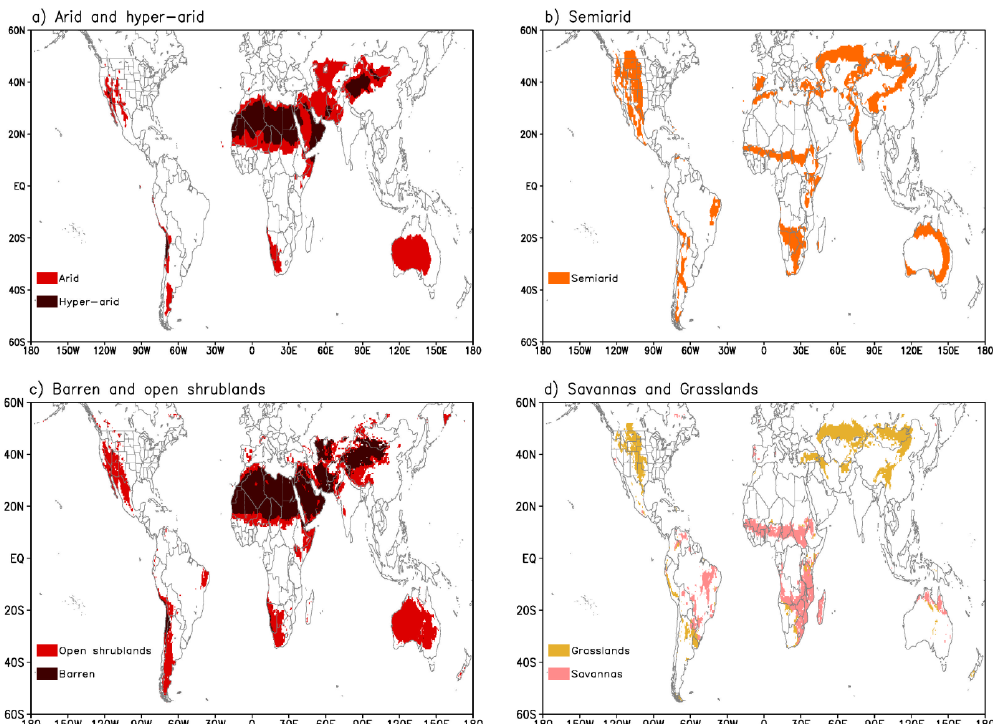
Fig. 2. Global distribution of (a) arid and hyper-arid and (b) semiarid regions derived from P /PET ratio based on observations versus corresponding surface vegetation types in (c) and (d) , respectively, from satellite Moderate-resolution Imaging Spectroradiometer (MODIS) observations (ISLSCP II MODIS (Collection 4, 2010) IGBP Land Cover, available online http://daac.ornl.gov/). On the lower left panel, the barren soil and open shrublands, respectively, are shown as dark red and red. On the lower right panel, the Savannas and Grasslands, respectively, are shown as pink and light